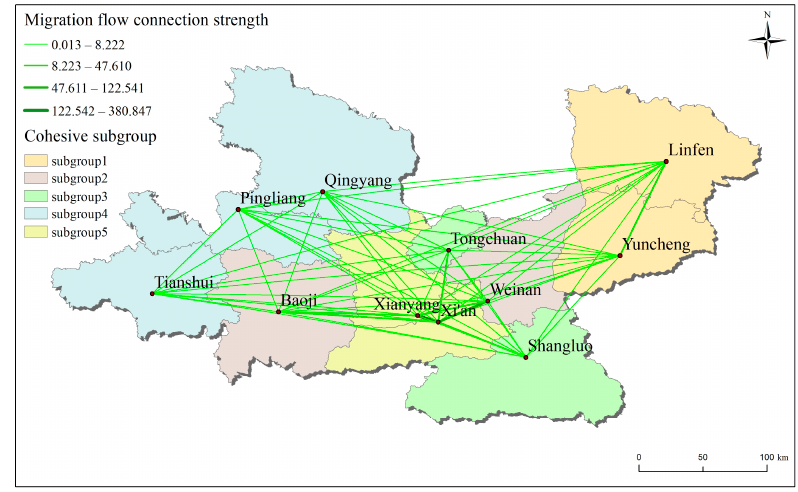
Figure 4. Spatial connection pattern of migration flow and analysis results of cohesive subgroups.